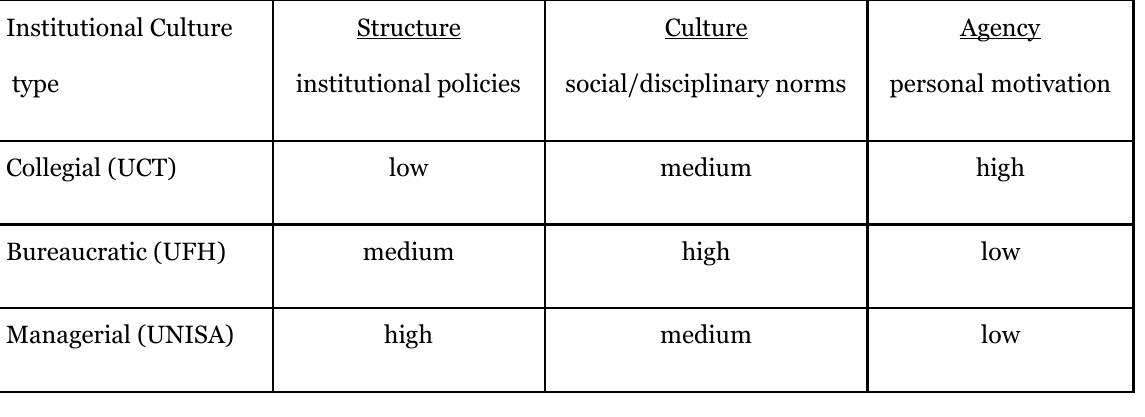
The Relative Importance (Low, Medium, High) of Structure, Culture, and Agency on Motivating OER Activities According to Institutional Culture